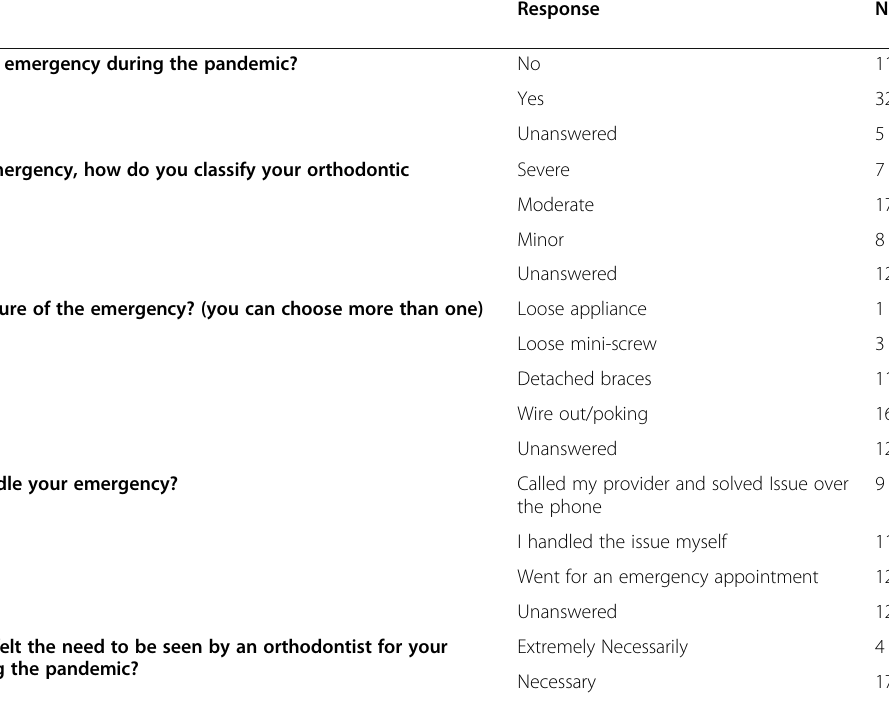
Table 3 Section 3: Handling emergencies during the pandemic Question Response Number %